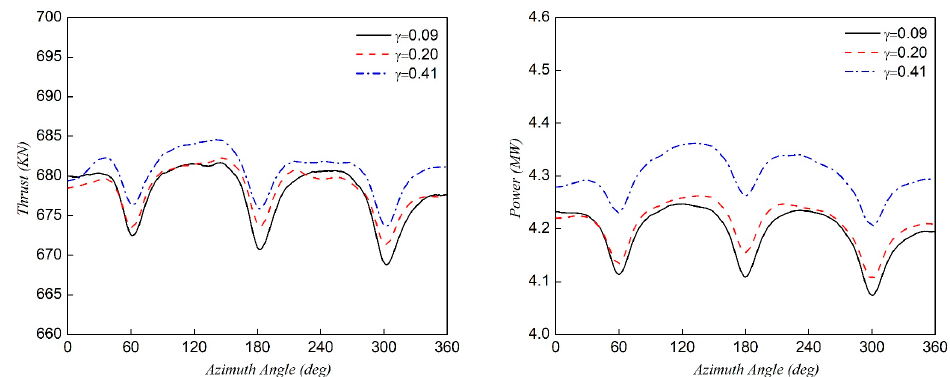
Table 9. The power for various wind shear exponents ( γ ) at 𝑉 (cid:3035)(cid:3048)(cid:3029) = 11.4 m/s ( 𝐼 (cid:3045)(cid:3032)(cid:3033) = 0.14, tilt angle = 4°). Figure 24. Thrust and power versus azimuth angle for various wind shear exponents ( γ ) at V hub = 11.4 m / s ( I ref = 0.14, tilt angle = 4 ◦